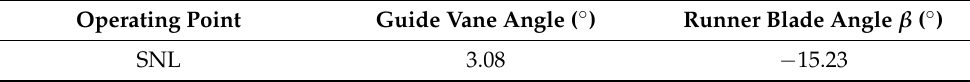
Table 1. Operating parameters of the Porjus U9 Kaplan prototype at